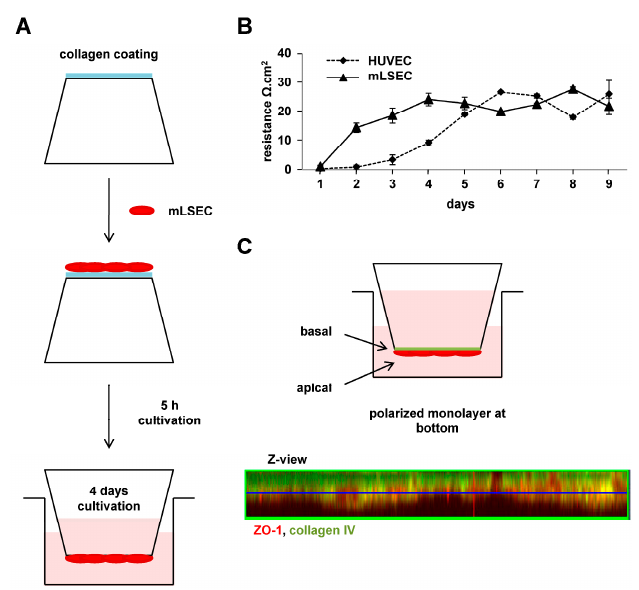
Figure 1. Endothelial integrity and polarity of the murine liver sinusoidal endothelial cell (mLSEC) monolayer. ( A ) Schematic drawing of plating the endothelial cells on the Transwell membrane. mLSEC cells were seeded onto the bottom of a collagen-coated Transwell membrane, allowed to attach for 5 h and subsequently cultivated upside-down for 4 days; ( B ) Transendothelial electrical resistance (TEER) analysis of mLSECs cultured upside-down onto the bottom of the Transwell membrane for up to 9 days. Human umbilical vein endothelial cells (HUVEC) cells were used as a control; ( C ) Confocal immunofluorescence analysis of ZO-1 and collagen IV showing basal and apical polarization of the mLSECs monolayer (Z-view).